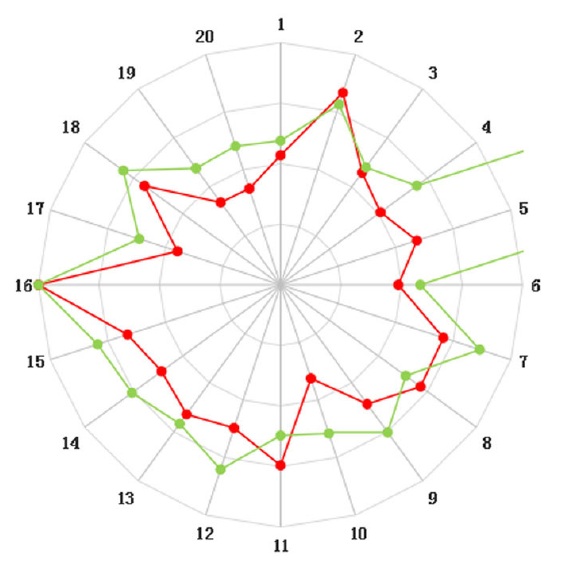
Figure 3: The scatter plots of the compounds identified in Cistanche based on principal component analysis (PCA). The red line is the uterine indices, and the green line is the MCF7 cell proliferation. The